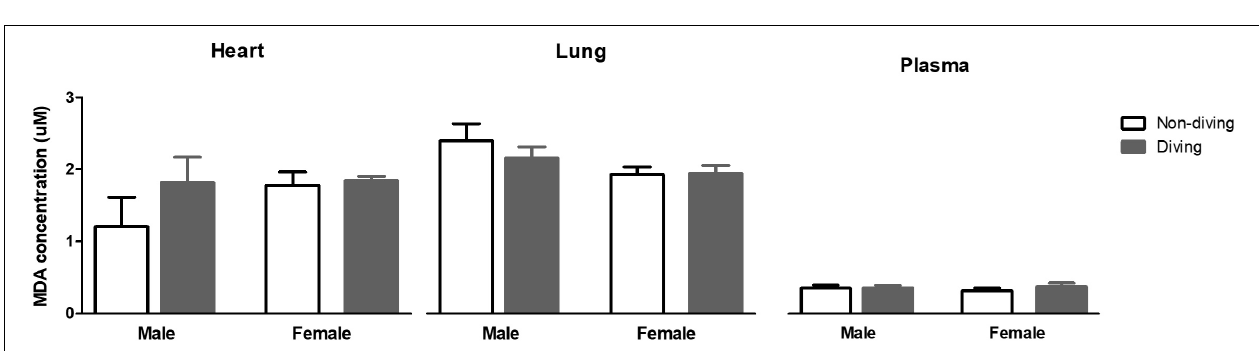
FIGURE 9 | (A) Relative expression of eNOS and p-eNOS proteins quantified by Western blot and normalized to pan-actin as housekeeping protein ApoE KO rats, (B) , relative expression of eNOS normalized to pan-actin (C) , p-eNOS/eNOS in lung tissue, n = 5. eNOS, endothelial nitric oxide synthase; p-eNOS, phosphorylated eNOS; D, diving; ANOVA and t -test.